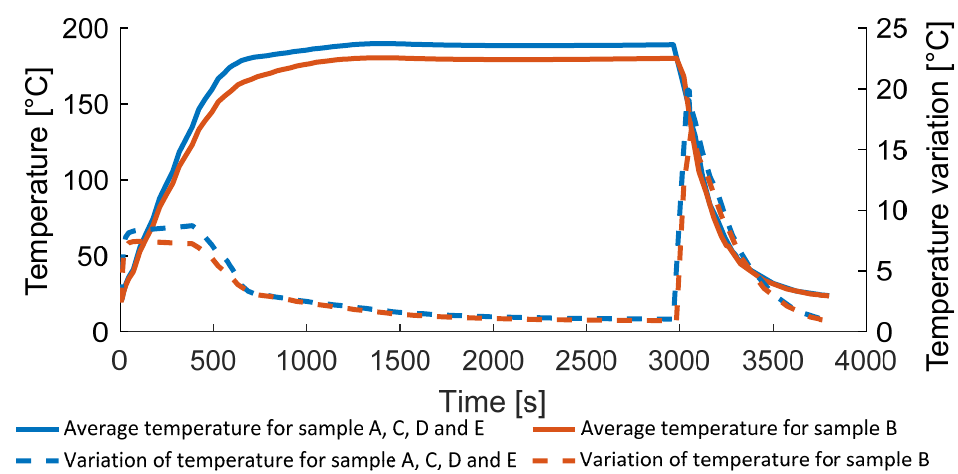
Figure 12. The average domain temperature and temperature variation.